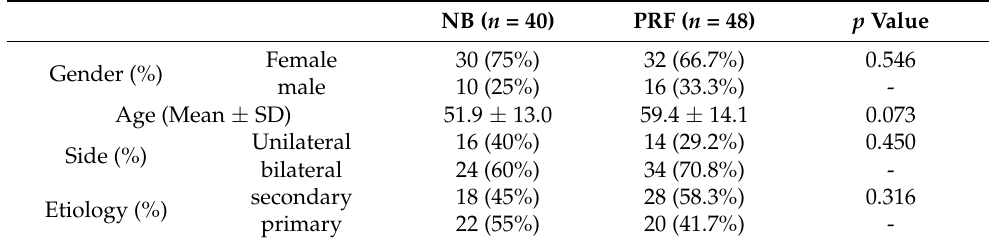
Table 1. Demographic characteristics of all patients. NB = nerve block, PRF = pulsed radiofrequency.